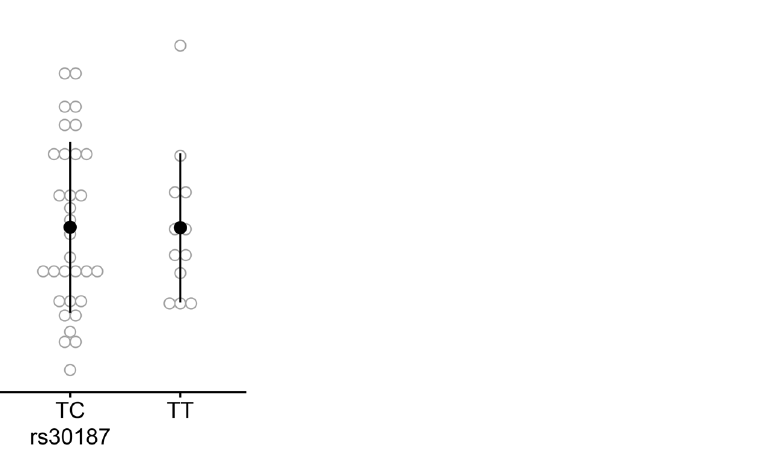
Figure 3. Plasma Ang II levels across rs30187 genotypic groups. Analysis of plasma Ang II concentration in pregnant women (n = 65). No difference was detected among genotypic groups (ANOVA, p =